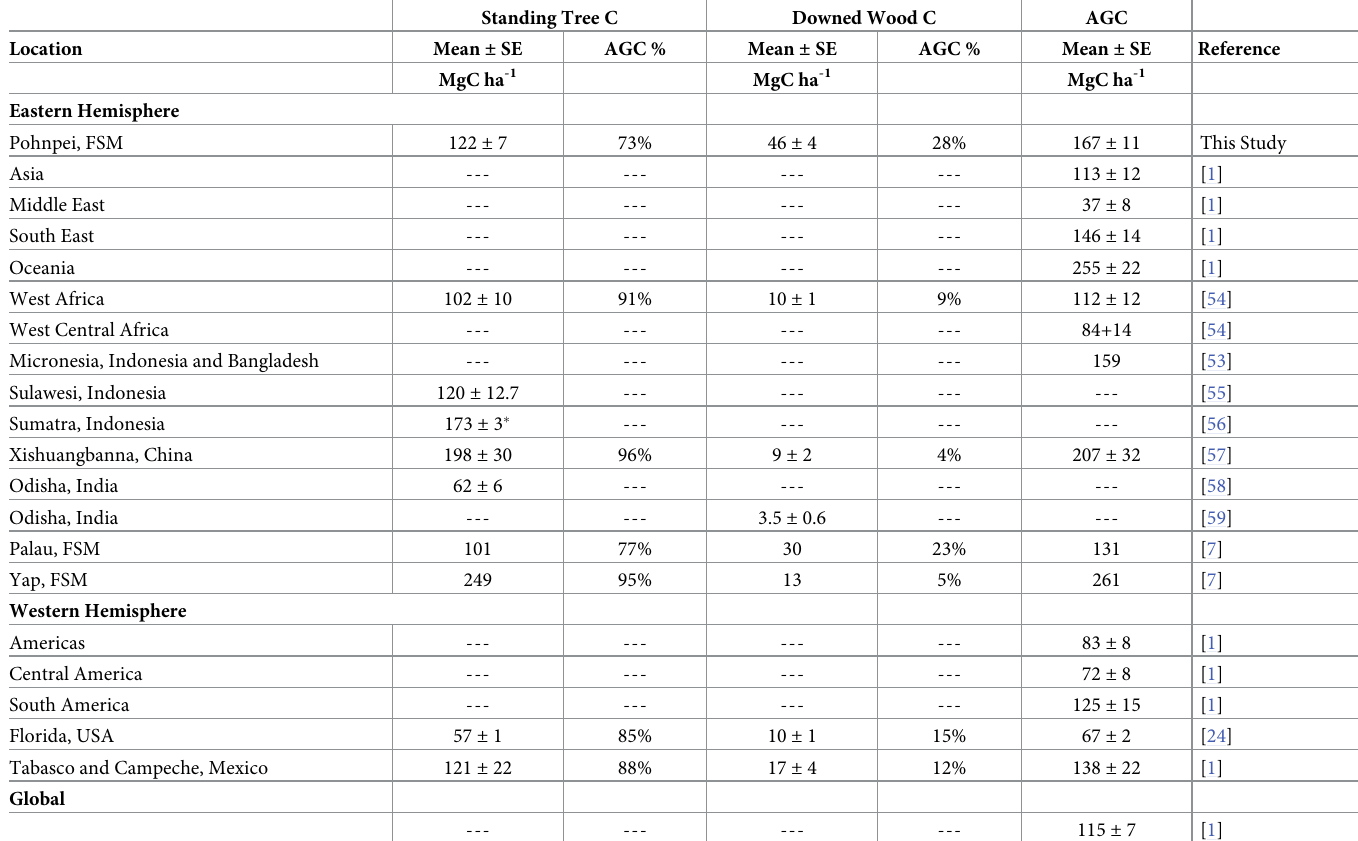
Table 3. Mangrove carbon stock from various locations world-wide.